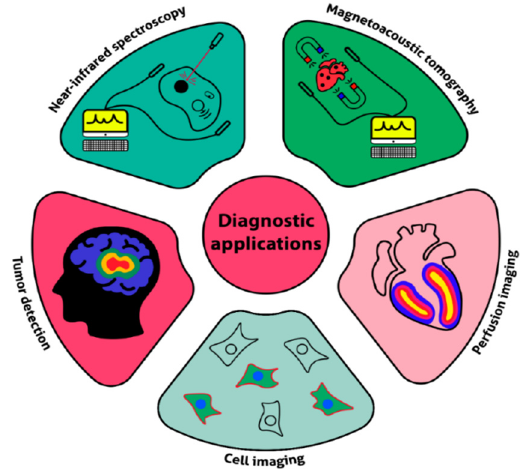
Figure 5. Diagnostics applications of MNPs via MRI and MPI techniques. Using T 1 contrast agents, the MRI image becomes brighter and T 2 darker. MNPs are often known to shorten the T 2 time, which leads to a dark zone on the MRI image. The MNP coating influences the relaxation time due to changes in water molecule availability near the magnetic core [28]. However, the universal recipe that obtains the best MRI agent is unknown [28]. In 1996, the FDA approved the Feridex ® T 2 -contrast agent for liver lesion detection. Feridex is a dextran-coated aqueous colloid of superparamagnetic MNPs. In the same period, several dextran-coated MNPs (e.g., Endorem, Resovist) were also approved for clinics. However, Feridex and some other contrast agents were withdrawn in 2009 due to side effects and major safety concerns (see Section 3, possible toxicity effects) [20]. Notably, the novel biocompatible MNP-based MRI contrast agents are still receiving attention for clinical use. There are a number of successful cell experiments, extensive safety experiments, and undergoing pre-clinical animal studies [20]. However, clinical trials for use in humans are not successful or in the early stages of investigations [20]. MPI is a relatively novel non-invasive technique [5]. MPI was first conceived in 2001 and reported in 2005. It uses changing magnetic fields to generate a signal from superparamagnetic MNP tracers. The signal can be observed without background, providing information about the probe location with a high signal-to-noise ratio. Among the applications of MPI are cell tracking, tumor detection, and blood-pool, vascular, and perfusion imaging (Figure 5) [5]. The high sensitivity of MPI is suitable for cancer detection in the early stage. Recently, various MNP-based constructions for multimodal imaging have been developed [20]. These include systems for simultaneous MRI and MPI detection and combinations with computed tomography (CT), single-photon emission computed tomography (SPECT), positron emission tomography (PET), optical and ultrasound imaging, and magneto-acoustic tomography [8,20,177,178]. Combining MNP-based imaging and therapeutic approaches provides possible theranostic construction production (Figure 6) [5,8,20]. Theranostic MNPs offer considerable potential for drug- resistant cancer treatment. The primary theranostic system combines MRI and chemotherapeutic drugs or hyperthermia treatment (Figure 6). The progress in this area is limited, but has increased over the last several years [5,7,8,20].